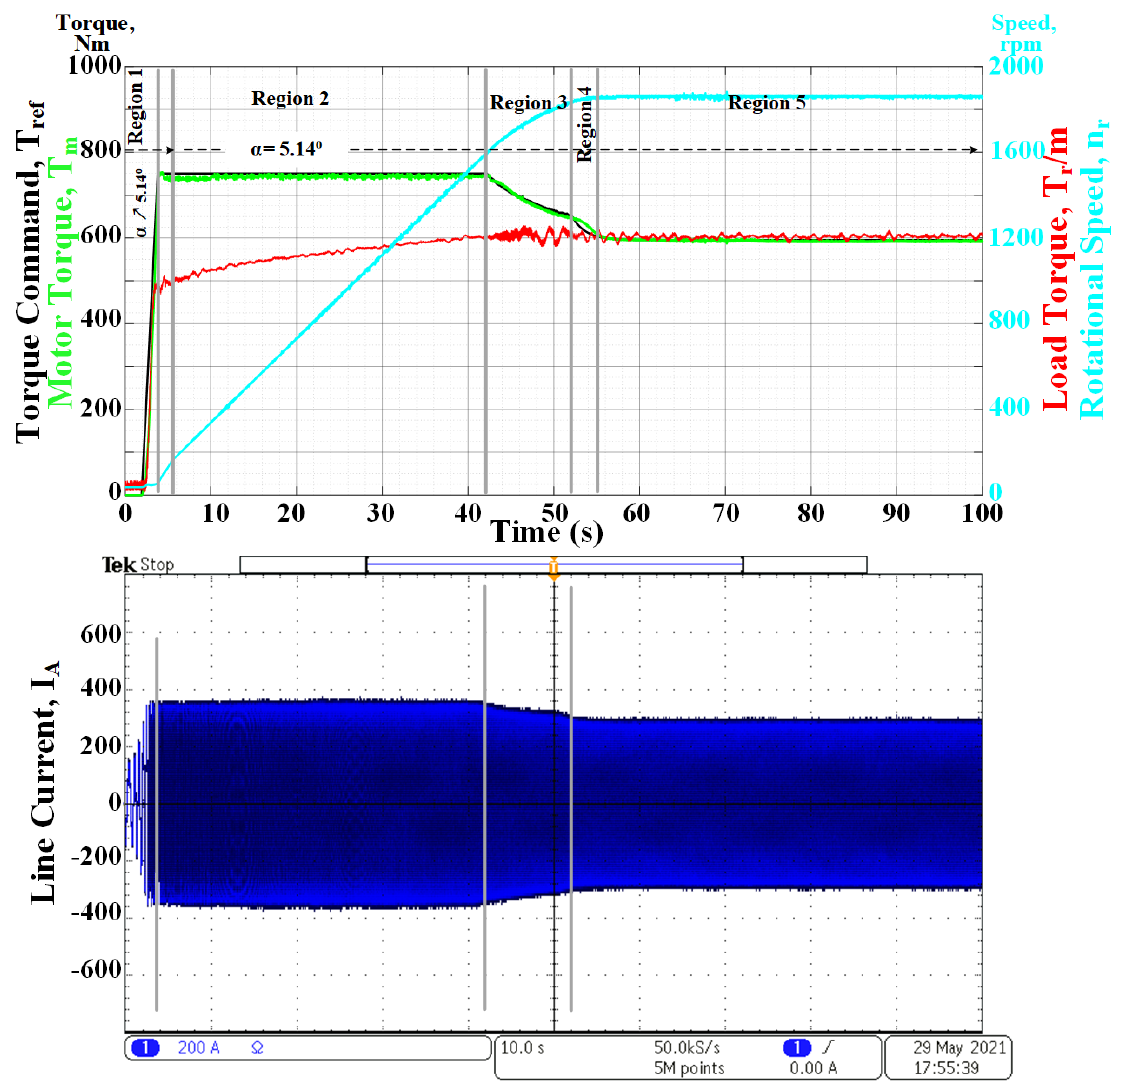
Figure 22. Acceleration and then constant speed operation on a track with a positive maximum slope. Region 1: Starting period, Region 2: Acceleration at maximum torque, Region 3: Acceleration at constant power, Region 4: Controller action for smooth transition from acceleration to constant speed operation, Region 5: Constant speed operation.